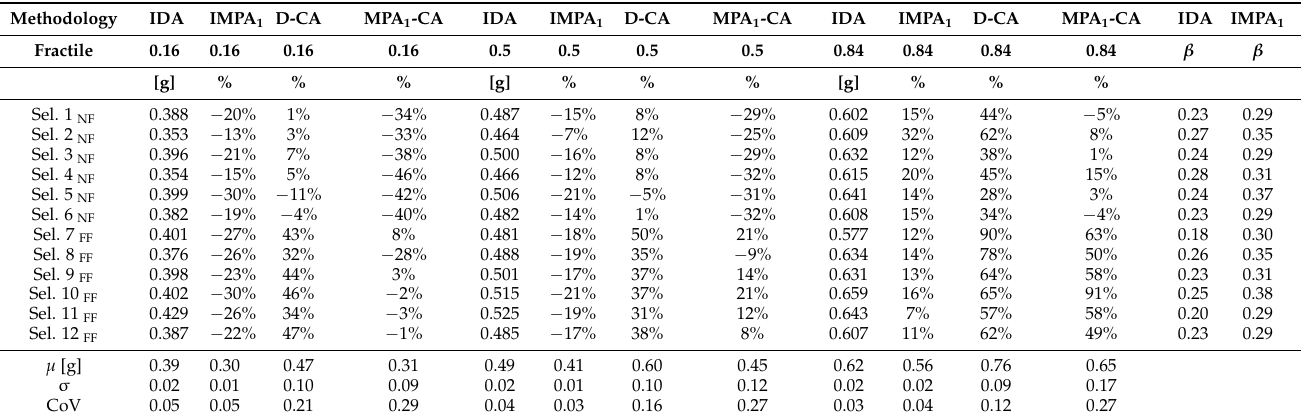
Figure 9. Histogram of mean values of fragility curves for different methodology and selection of records. Table 3. Percentage variation of the 16th percentile, mean and 84th percentile of fragility curves for different methods with respect to IDA.